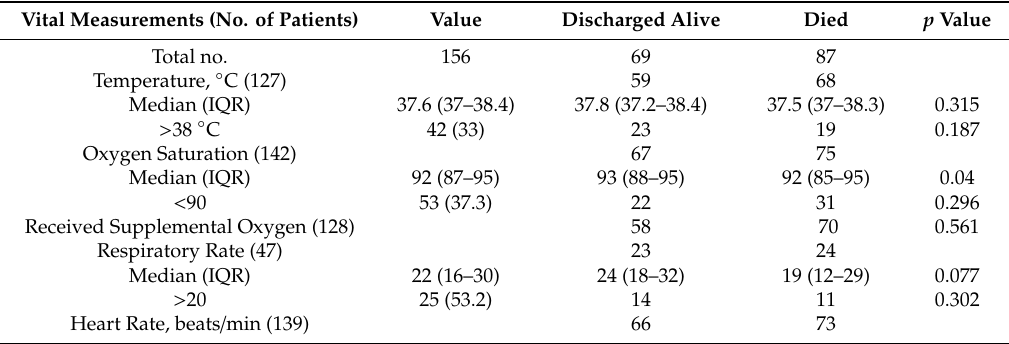
Table 2. Vital signs, radiological findings, and laboratory results in patients with Covid-19 on admission to